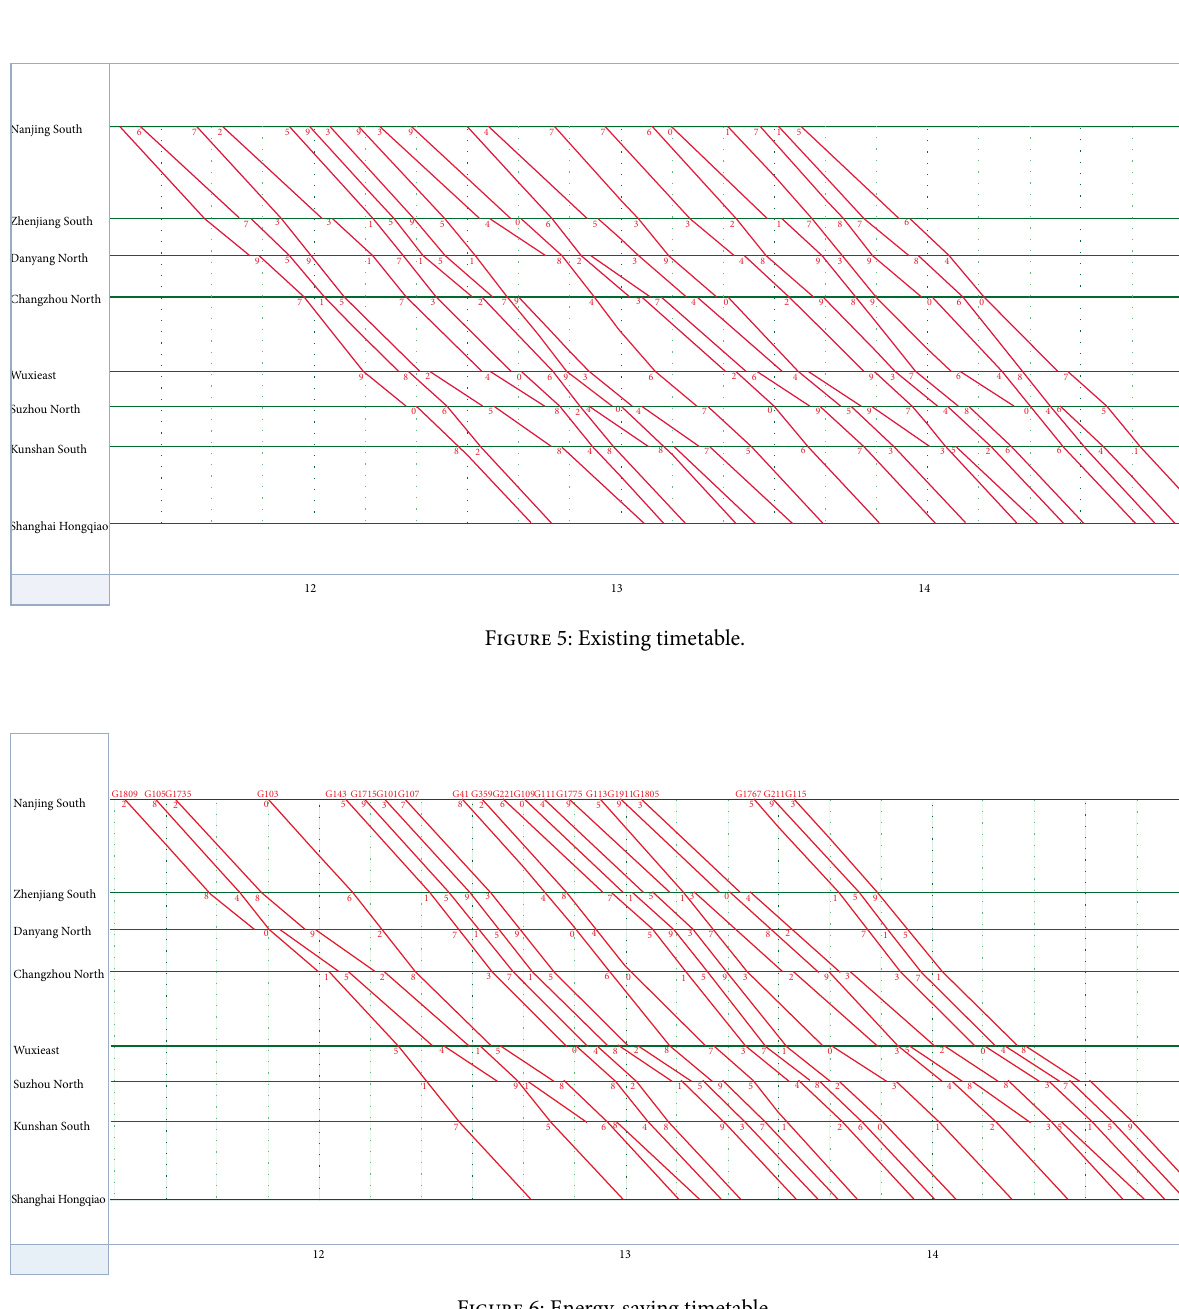
Figure 6: Energy-saving